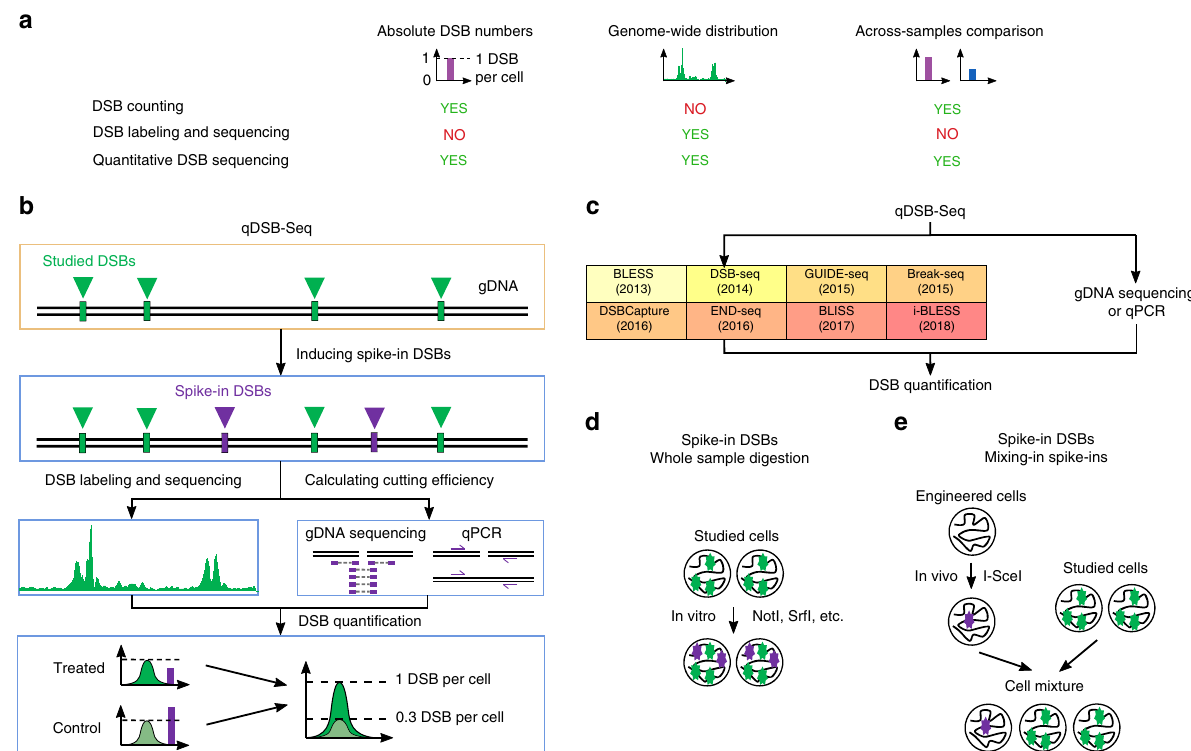
Fig. 1 Quantitative DSB sequencing (qDSB-Seq) method. a A comparison of current DNA double-strand break (DSB) counting (e.g., immuno fl uorescence microscopy, quantitative PCR (qPCR)) and DSB sequencing strategies (e.g., BLESS 3 , i-BLESS 15 , END-Seq 6 , Break-Seq 4 , DSBCapture 5 ) with our qDSB-Seq method. b In qDSB-Seq protocol after DSB induction cells are treated with a restriction enzyme to introduce site-speci fi c, infrequent DSBs (spike-ins). Next, DSBs are labeled (here using i-BLESS 15 or BLESS 3 ) and sequenced. Simultaneously, genomic DNA (gDNA) sequencing (or qPCR) is performed and used to estimate the cutting ef fi ciency of the enzyme, and thus frequency of induced spike-in DSBs, which is then used to quantify the absolute DSB frequencies (per cell) of studied DSBs in the sample (Methods). c qDSB-Seq can be combined with any sequencing-based DSB labeling method. d , e Spike-in DSBs were induced in two different ways: d the studied cells were digested using the NotI, SrfI, AsiSI, or BamHI restriction enzyme in vitro; e cells expressing a restriction enzyme in vivo were mixed with the studied cells (I-SceI digestion) or alternatively a restriction enzyme was expressed in vivo in all studied cells (DIvA cells discussed